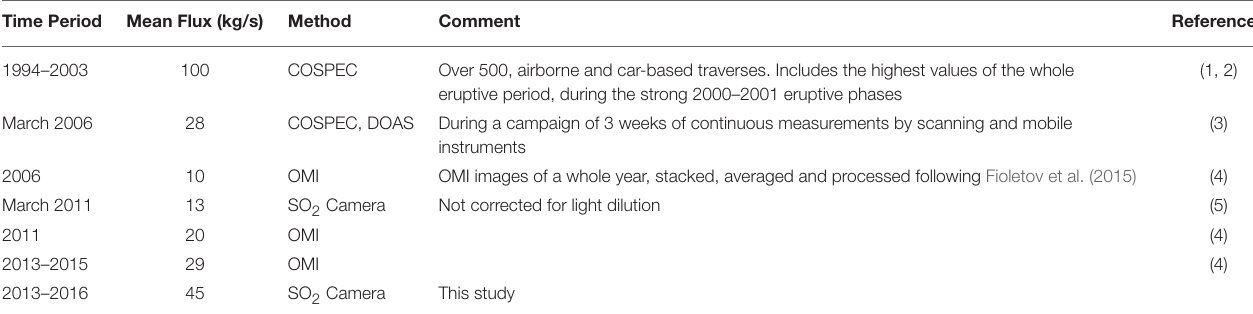
TABLE 2 | Comparison of all the published data reporting SO 2 fluxes for Popocatépetl volcano. Time Period Mean Flux (kg/s)